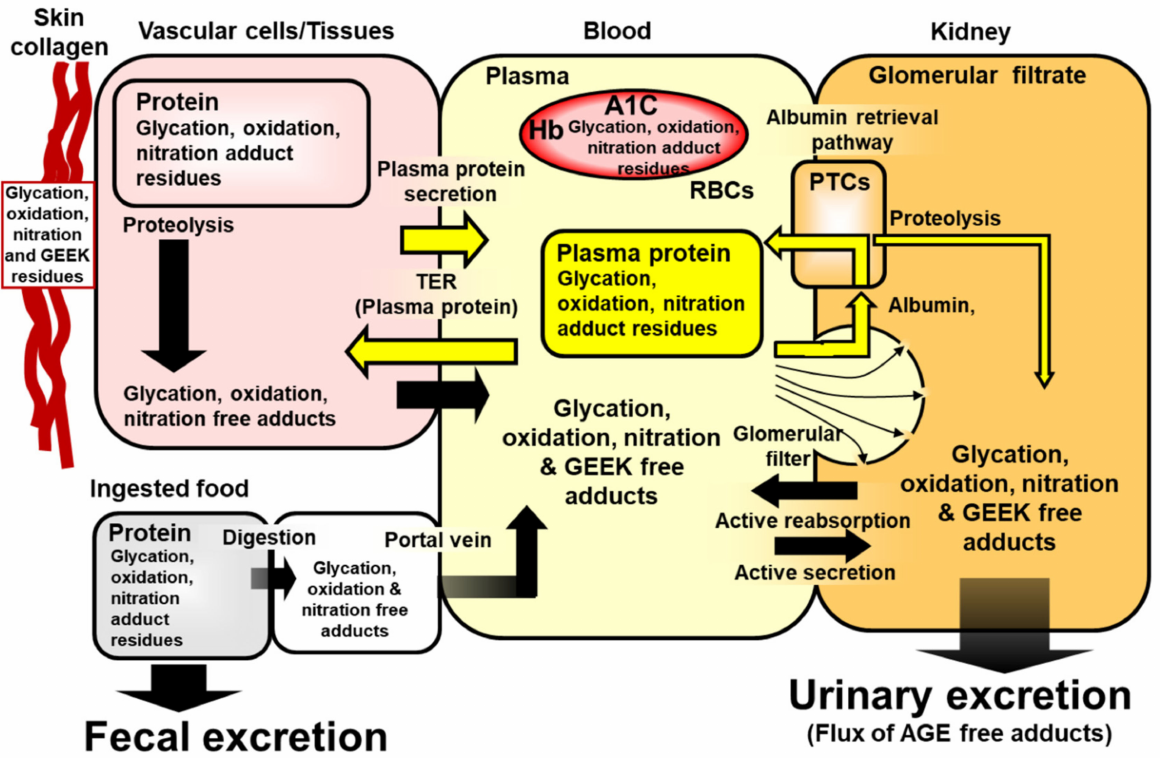
Figure 1. Schematic multicompartment representation of the formation, physiological processing and transit of protein glycation, oxidation, nitration and GEEK adducts in mammalian